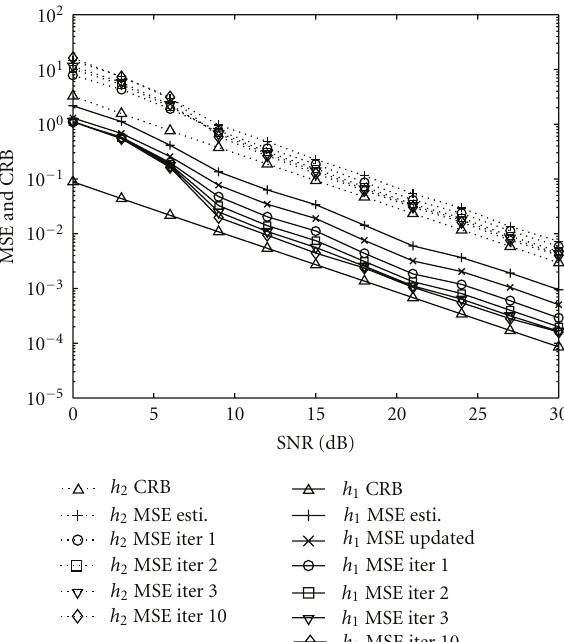
Figure 2: CFO estimation MSE versus SNR: N = 24.